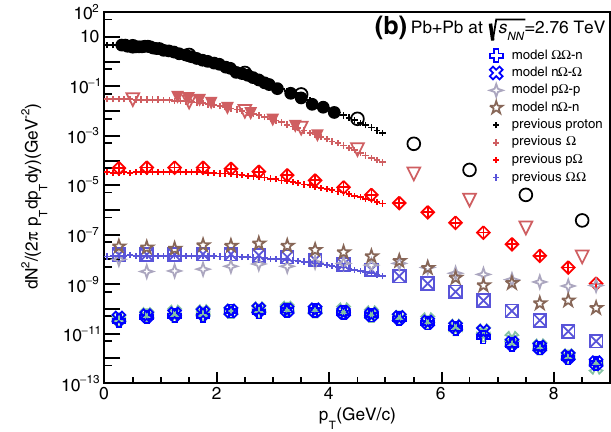
Fig. 4 Transverse momentum p T spectra of proton calculated by the folding model, the open makers for (cid:3) nn , (cid:3) pp , (cid:3)(cid:3) n and (cid:3)(cid:3) p are the results of the BLWC model and the folding model. The full makers are